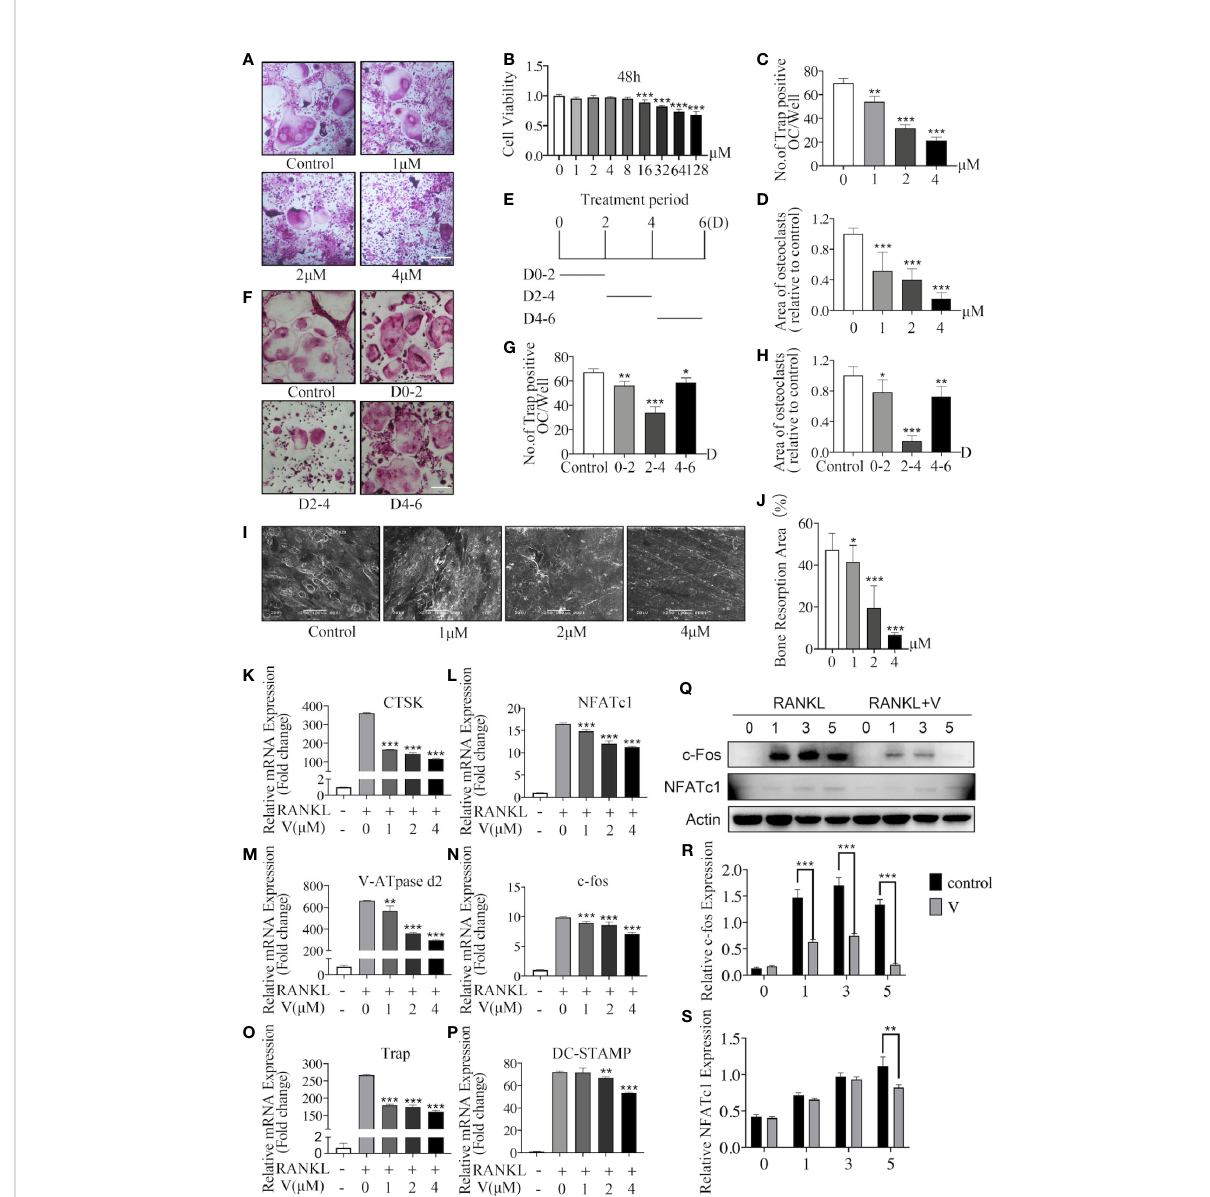
FIGURE 4 Velutin inhibits nuclear factor- k B receptor activator ligand (RANKL)-induced osteoclast formation and bone resorption in vitro . (A) Bone marrow-derived macrophages (BMMs) were grown for 6 days with M-CSF and RANKL, as well as varied velutin concentrations, before being stained for TRAP detection. Osteoclasts were de fi ned as cells with three nuclei or less. (n = 3); scale bar: 200 m m. (B) CCK-8 assays showing the cytotoxicity of velutin in BMMs (n = 5). (C-D) Analysis of number and size (area) of TRAP ‐ positive multinucleated (nuclei > 3) cells (n = 3). (E) Schematic diagram of the timeline of BMM cells treated with velutin. (F) BMMs were cultivated in complete medium, then treated with velutin (4 m M) and stained for TRAP on the days indicated; scale bar: 200 m m. (G-H) Analysis of number and size (area) of TRAP ‐ positive multinucleated (nuclei > 3) cells (n = 3). (I-J) Bone tissue samples were used to cultivate M-CSF-dependent BMMs, then stimulated with RANKL and the speci fi ed velutin doses. SEM examination observed bone resorption lacunae after 15 days, which were calculated as percentages using Image J program (n = 3). (K – P) qPCR result of RANKL-induced osteoclast-related genes ’ relative expression levels. Expression of target genes was adjusted to b -actin and expressed as fold change compared to the controls group (n = 3). (Q – S) M-CSF-dependent BMMs were serum- starved and pretreated for 2 h with velutin (4 m M) or vehicle control, before being stimulated with RANKL for the durations indicated times (0, 5, 15, 30, and 60 min). Western blot analysis was used to extract total cellular protein for protein expression levels (n = 3). Data are presented as mean ± SD; * P < 0.05, ** P < 0.01, and *** P < 0.001, in comparison to cells treated only with